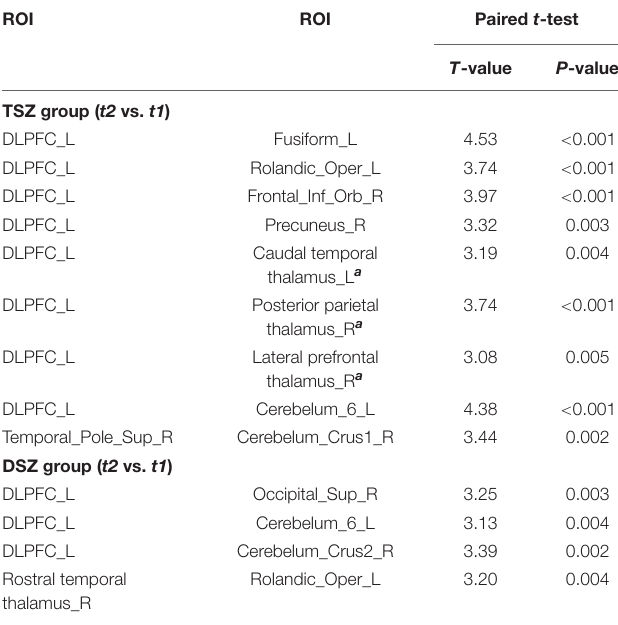
T -value P -value